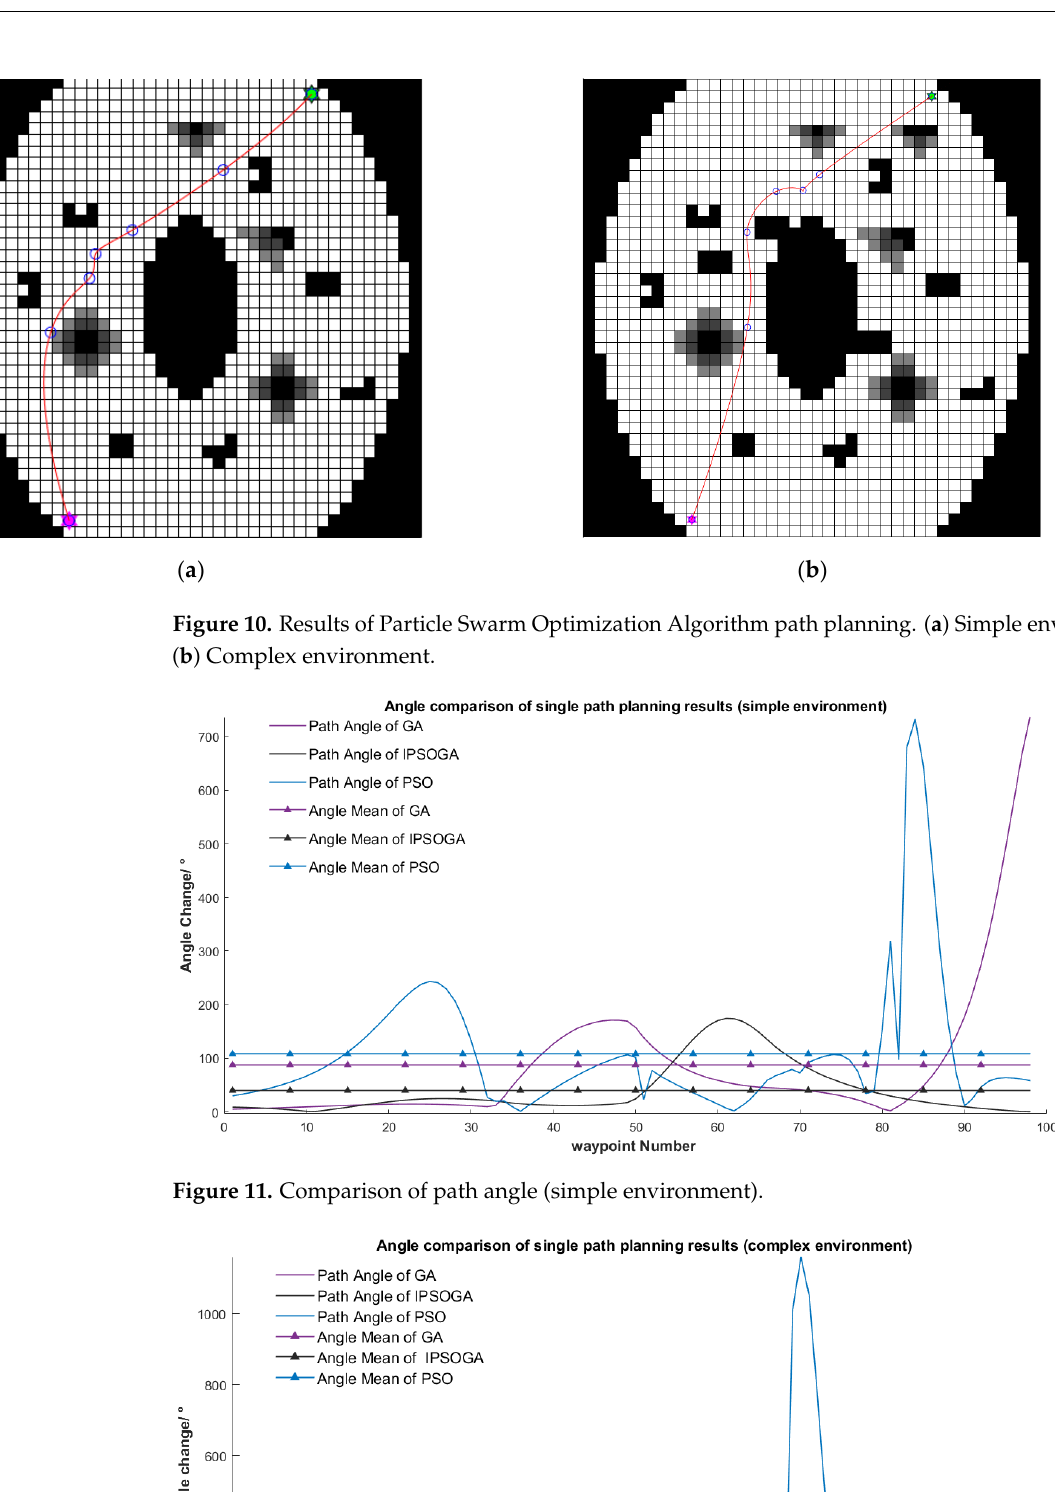
Figure 9. Results of Traditional Genetic Algorithm path planning. ( a ) Simple environment; ( b ) Com- plex environment.